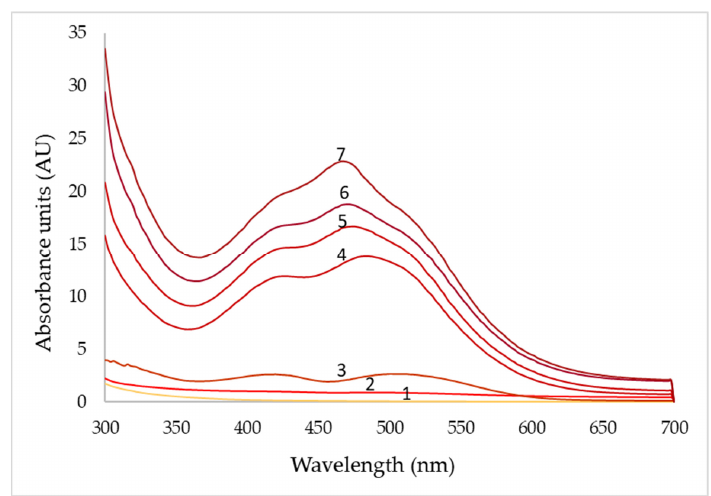
Figure 7. Absorbance scans of extracellular pigments (contained in the liquid broth) by spectrophotometry produced from days 1–7 for the culture of T. albobiverticillius 30548 at 24 °C, pH 5, with pO 2 at 50%. Colored spectra indicates the production of pigments with respect to hues from day 1 to 7.